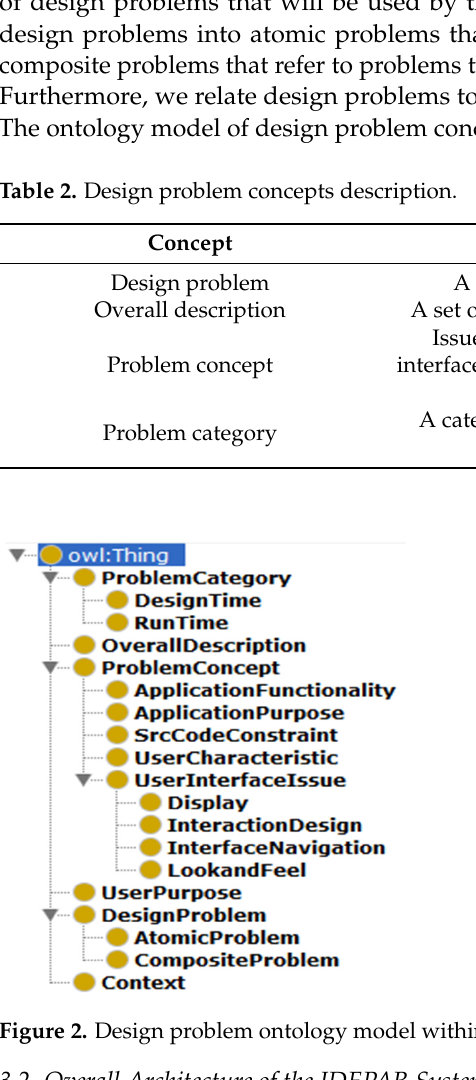
Figure 1. IDEPAR system within the AUIDP framework ( a ) IDEPAR system, ( b ) ICGDEP system.